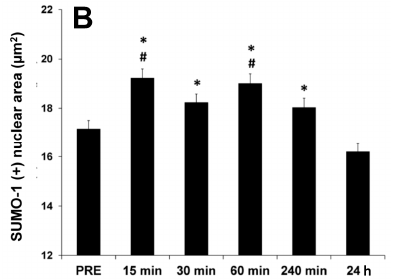
Figure 4. Representative immunofluorescence staining of SUMO-1 in myonuclei and quantification of SUMO-1 accumulated nuclear area. ( A ) Representative images of nuclear SUMO-1 localization within skeletal muscle myonuclei at baseline (PRE) as well as, 15, 30, 60, 240 min and 24 h post RE (630× magnification). SUMO-1 (Alexa 555, Red), myonuclei (Draq5, Blue) and MyHC I (Alexa 488, Green). SUMO-1 localization at PRE and 24 h post RE was preferentially located in perinuclear regions and closely to the nuclear envelope. Nuclear SUMO-1 localization increased from 15 min up to 60 min post resistance exercise but was reduced at 240 min and associated with a significant reduction of intranuclear SUMO-1 accumulation within 24 h; ( B ) Quantification of SUMO-1 stained nuclear area as determined in DAB-stained myofibres (compare Figure 2A,B) from PRE to 24 h post RE (Mean ± S.E.M). (#) significant different compared to PRE for ( p < 0.01); (*) significant different compared to 24 h values ( p < 0.01).